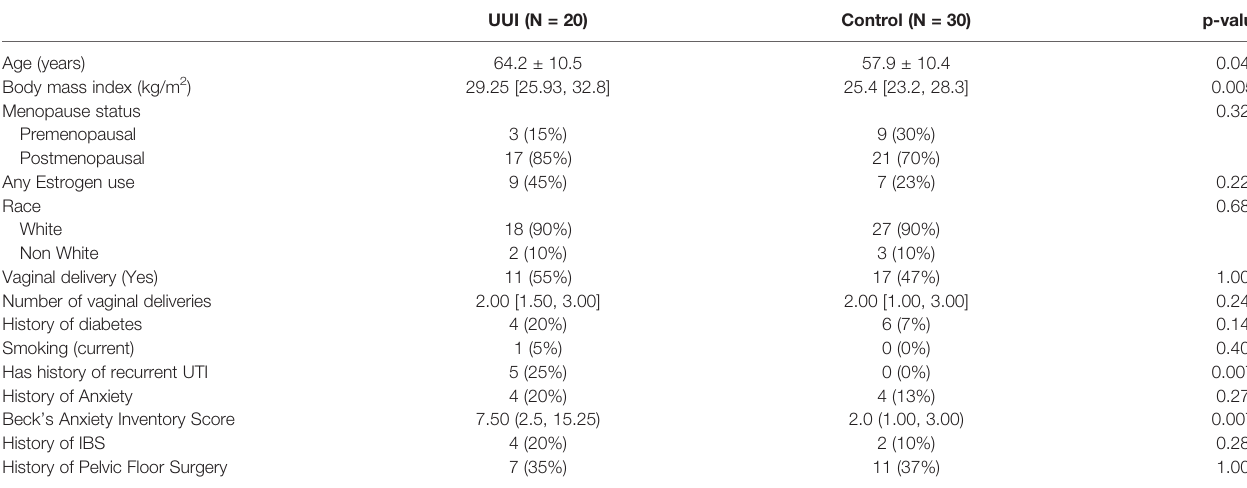
TABLE 1 | Participant demographics and comorbidities.